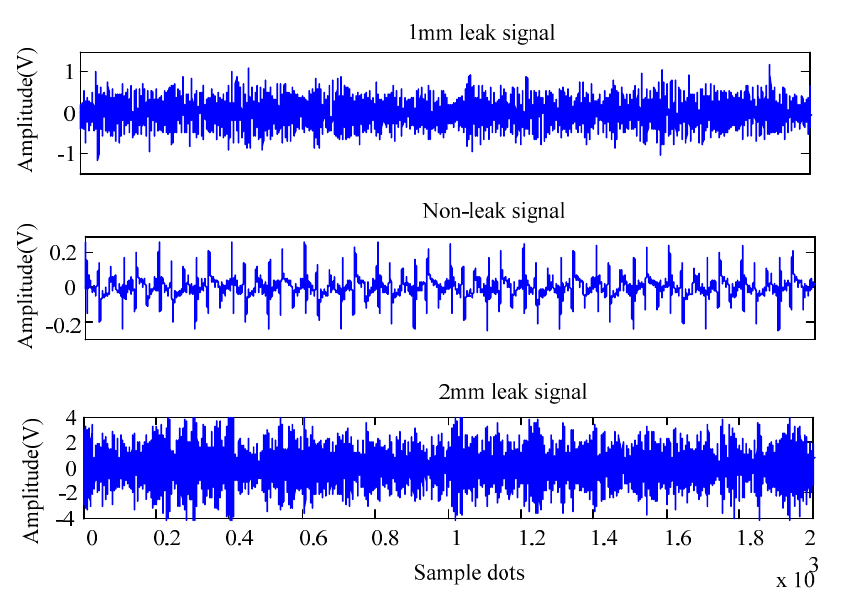
Figure 6. Signals collected by sensors.